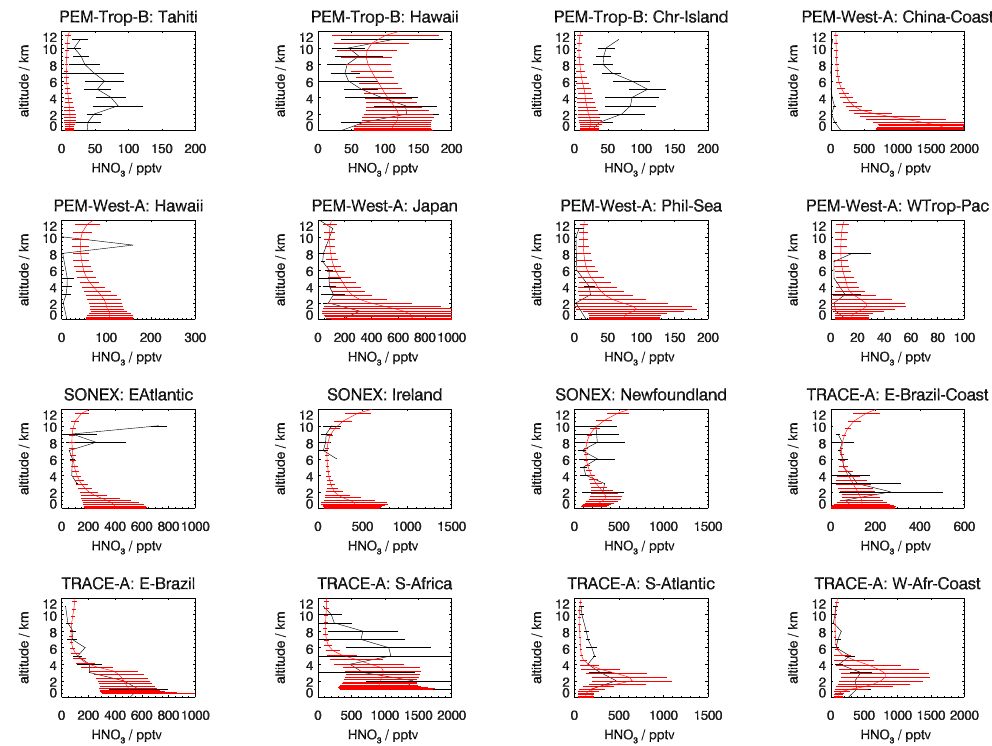
Fig. 20. Comparison between regional vertical profiles of modelled (red) and observed (black) HNO 3 from various aircraft campaigns compiled into data composites by Emmons et al. (2000). In each case, the mean concentration in each altitude bin is plotted and the horizontal lines represent the mean ± 1 standard deviation.